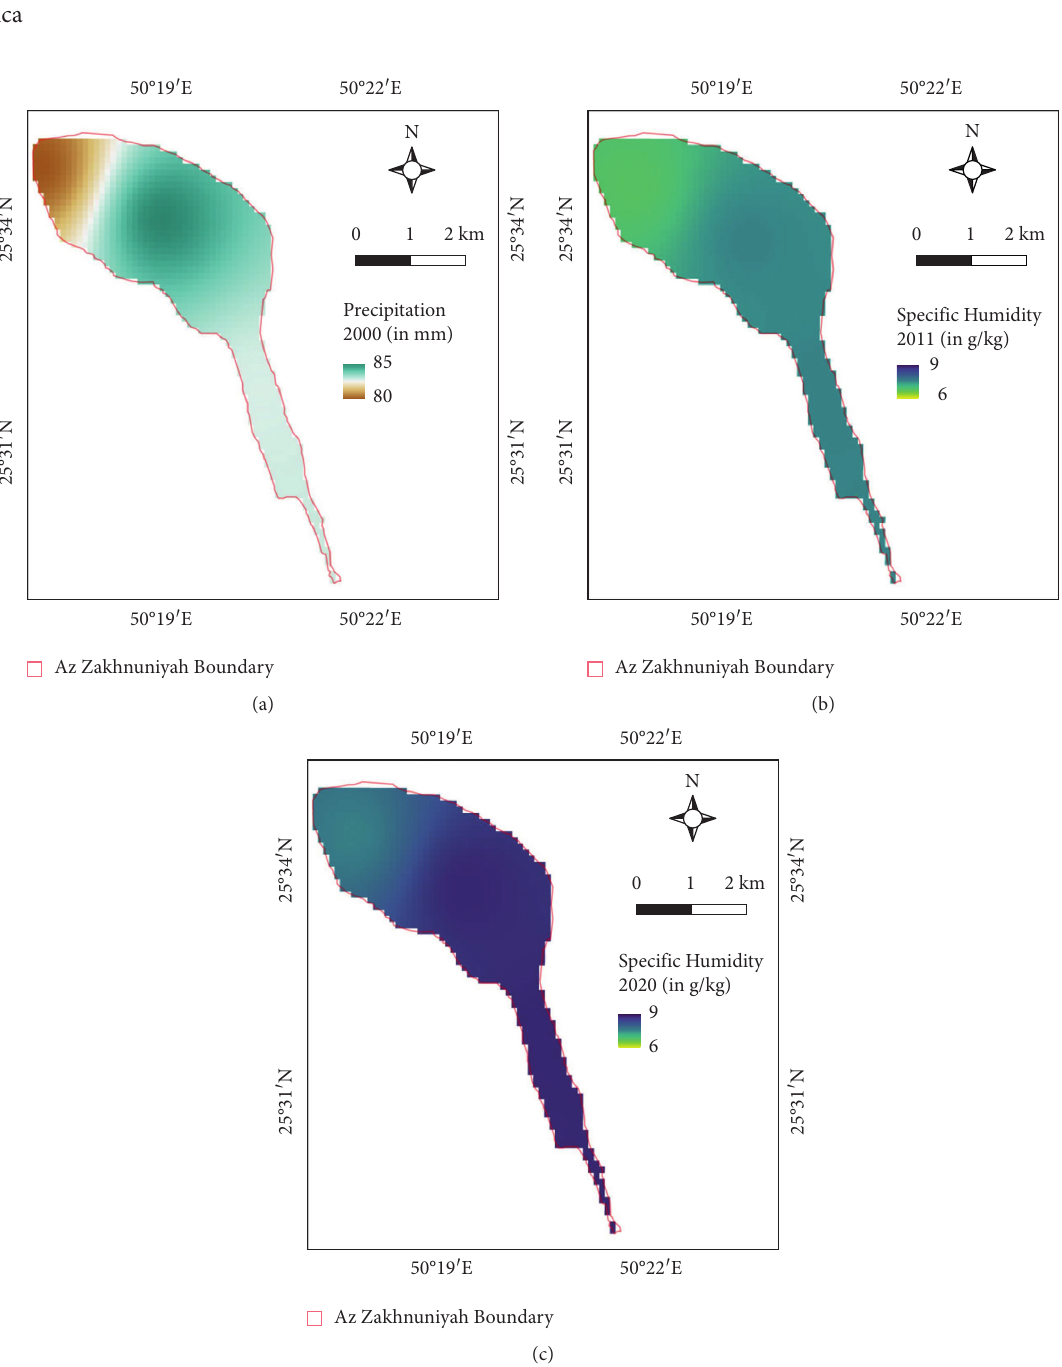
Figure 12: Specific humidity map (in g/kg) of study area for (a) 2000, (b) 2011, and (c)